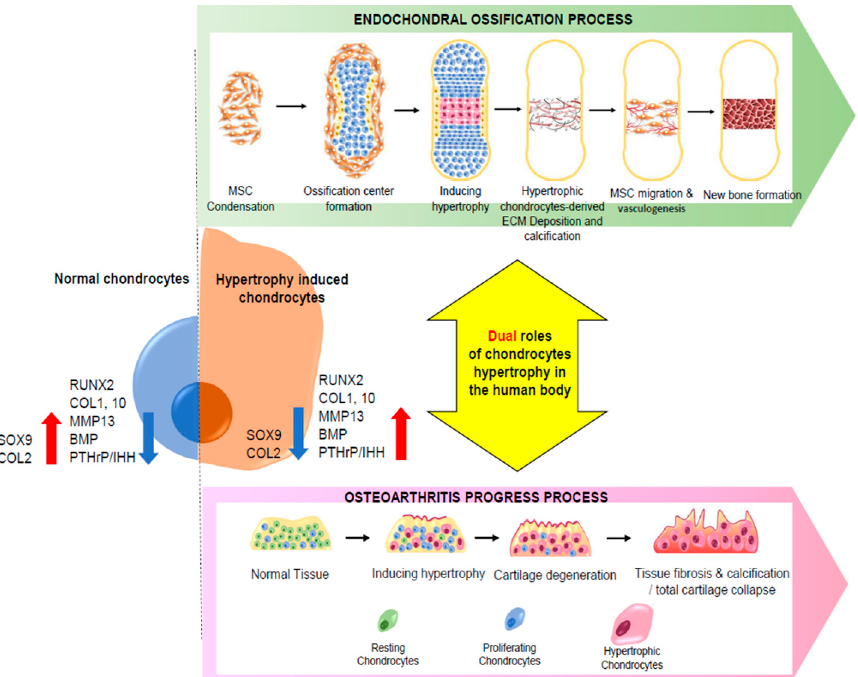
Figure 1. Schematic diagram of the dual role of chondrocyte hypertrophy in human physiology. Chondrocytes undergoing hypertrophy show different profiles of gene expression, ECM components, and secretome than those of undifferentiated chondrocytes. Hypertrophy-induced chondrocytes play different roles under different biological conditions.